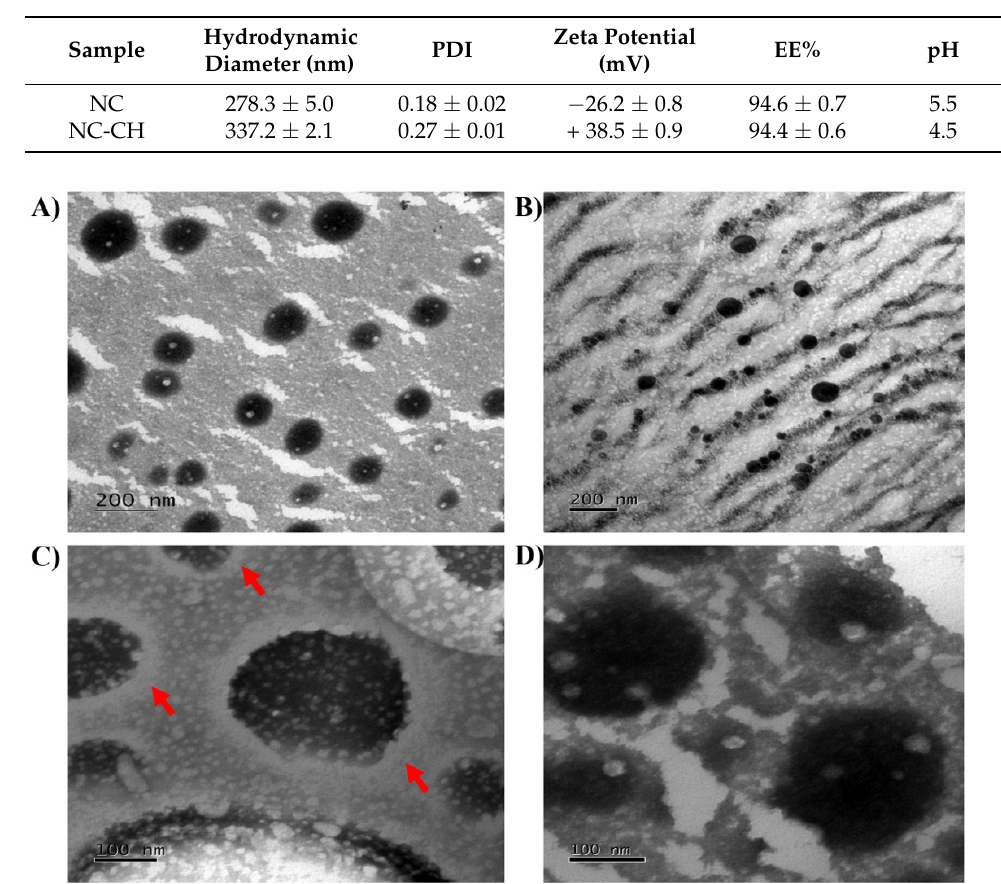
Table 2. Characterization of chitosan-coated (NC-CH) and uncoated nanocapsules (NC), including hydrodynamic diameter (nm), polydispersity index (PDI), zeta potential (mV), entrapment efficiency (%), and pH ( n = 3).